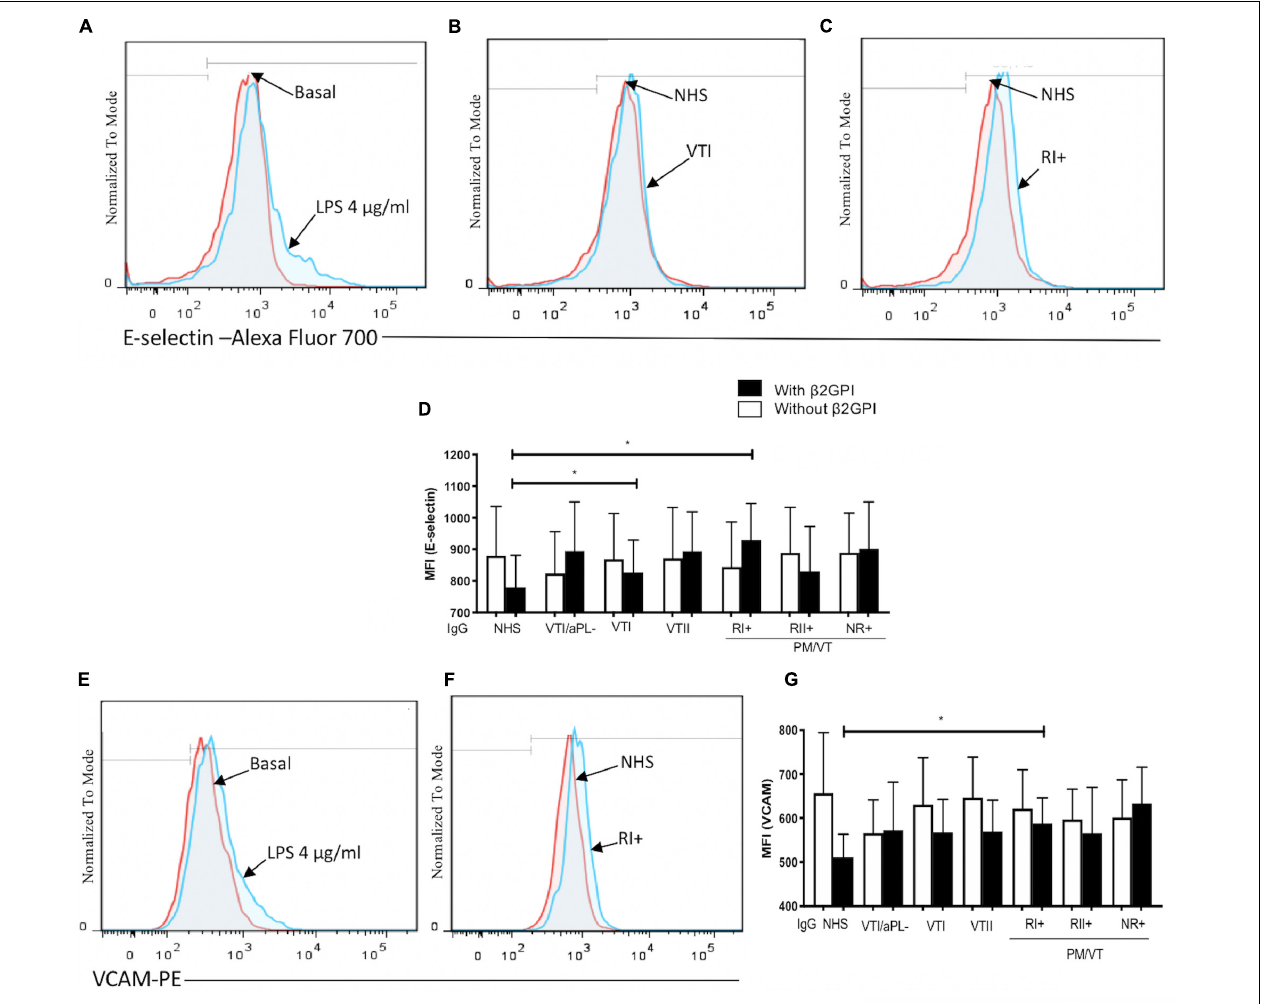
FIGURE 1 | Immunoglobulin-G (IgG) from patients with primary antiphospholipid syndrome (APS) [primary thrombotic APS (VTI) and refractory primary obstetric APS (RI+)] induced an increase in the adhesion molecule expression in human umbilical vein endothelial cells (HUVECs). (A,E) Lipopolysaccharide (LPS) at a concentration of 4 µ g/ml was included as a positive control, and the increased E-selectin and vascular cell adhesion molecule 1 (VCAM-1) expression was compared with unstimulated cells. (B–D) The median fluorescence intensity (MFI) of E-selectin increased in HUVECs stimulated with beta 2-glycoprotein-I ( β 2GPI) and IgG from patients with VTI and RI+ compared with the IgG/normal human serum (NHS) control. (F,G) The MFI of VCAM-1 increased in HUVECs stimulated with β 2GPI and IgG from patients with RI+ compared with the IgG/NHS control. A two-way ANOVA and the Holm–Sidak post-test (* p < 0.05 and ** p < 0.01) were performed. The results were obtained from three independent experiments. (A–C,E,G) Representative histograms. PM/VT, pregnancy morbidity and vascular